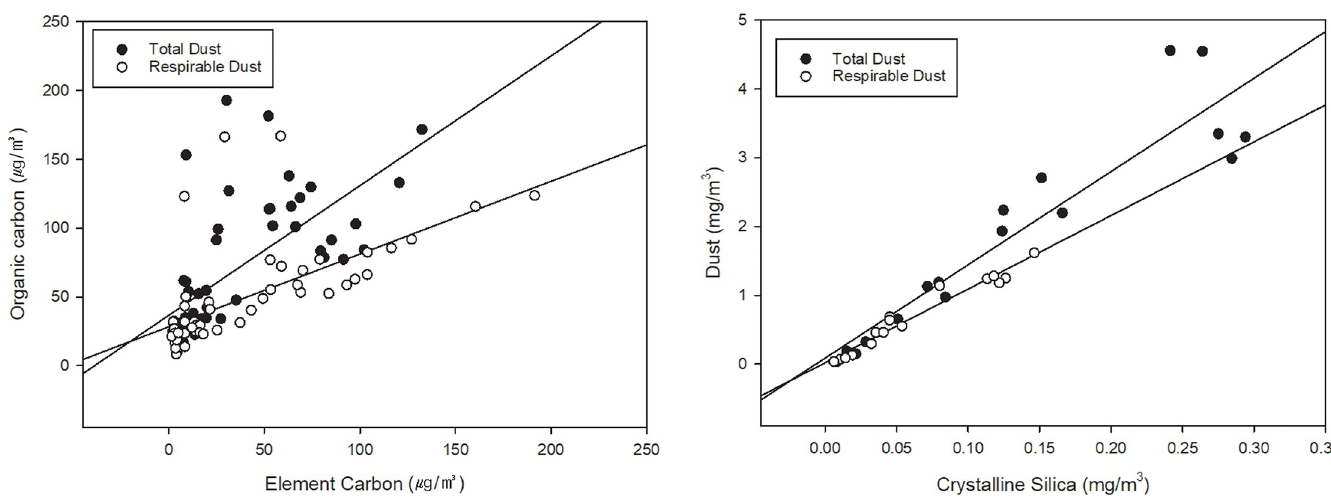
Fig 4. Correlation between (a) element carbon and organic carbon, (b) crystalline silica and dust.